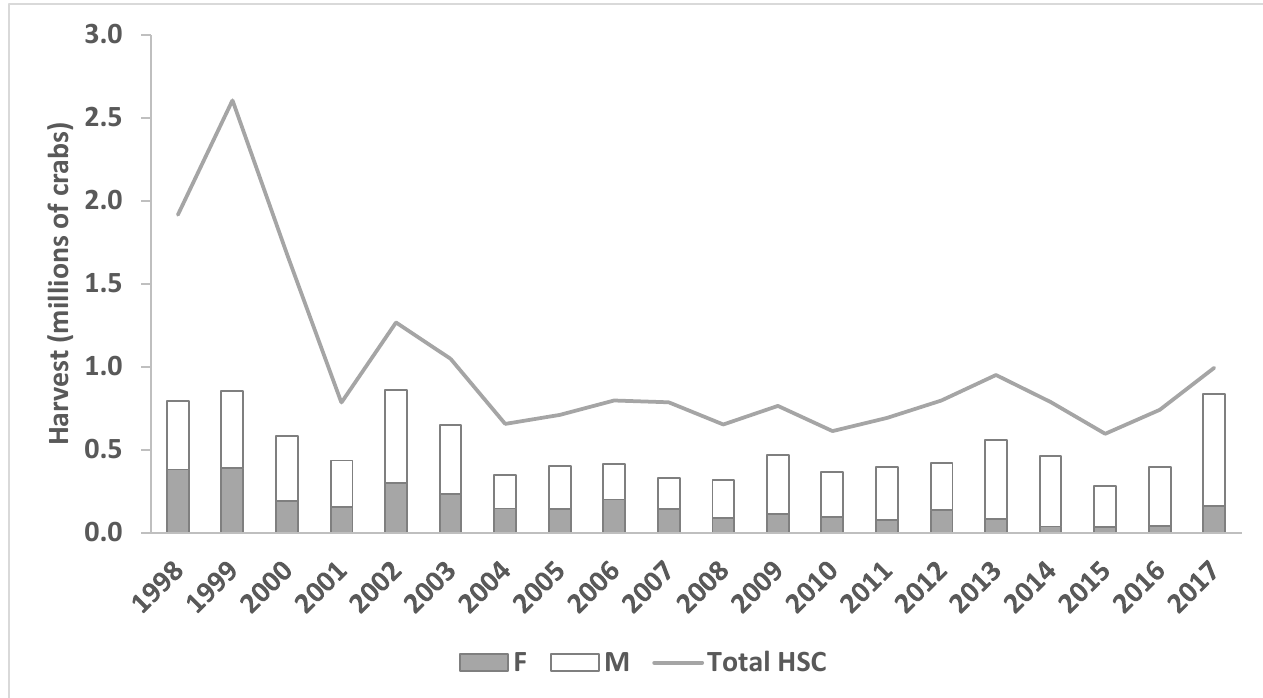
Figure 1. Coastwide horseshoe crab bait landings, 1998-2017, in numbers and by sex. Not every state along the Atlantic coast provides comprehensive sex data and therefore some are unclassified. Landings from 1998-2016 were validated by ACCSP; 2017 landings came from the 2018 FMP Review and state compliance